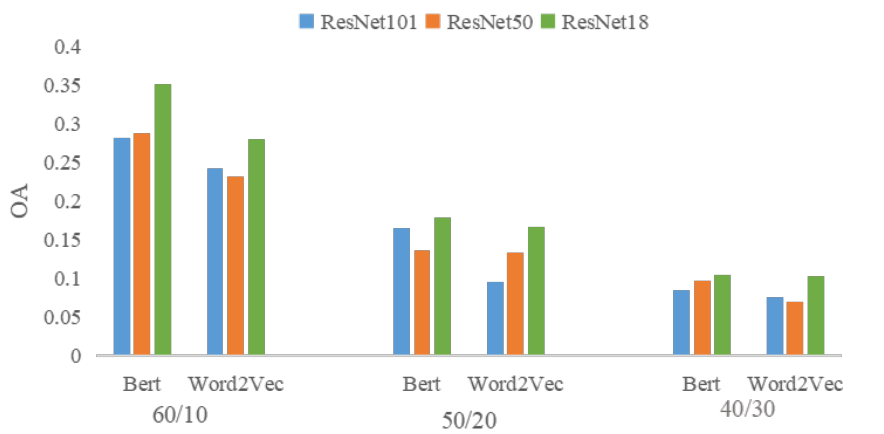
Figure 5. The results of the experiment of evaluating the impact of different visual feature extractors.